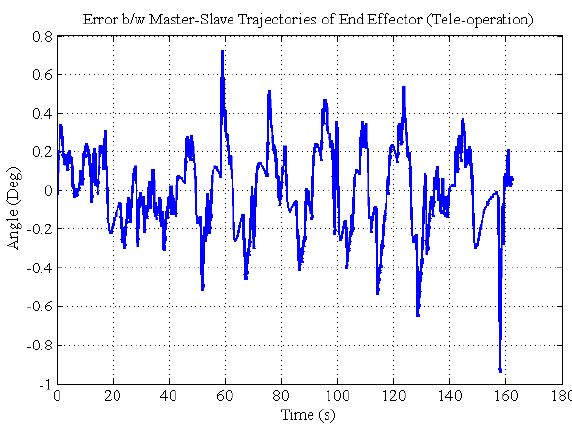
Figure 11. Error between the end effector trajectories for master and slave.